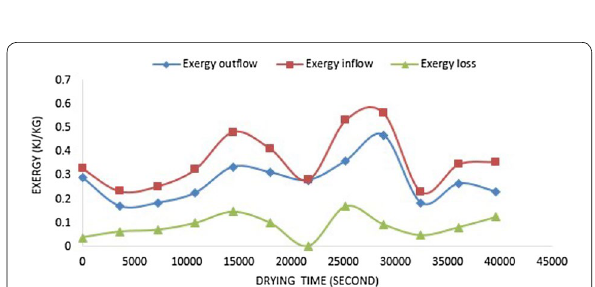
Fig. 11 Exergy as a function drying time (2nd day)